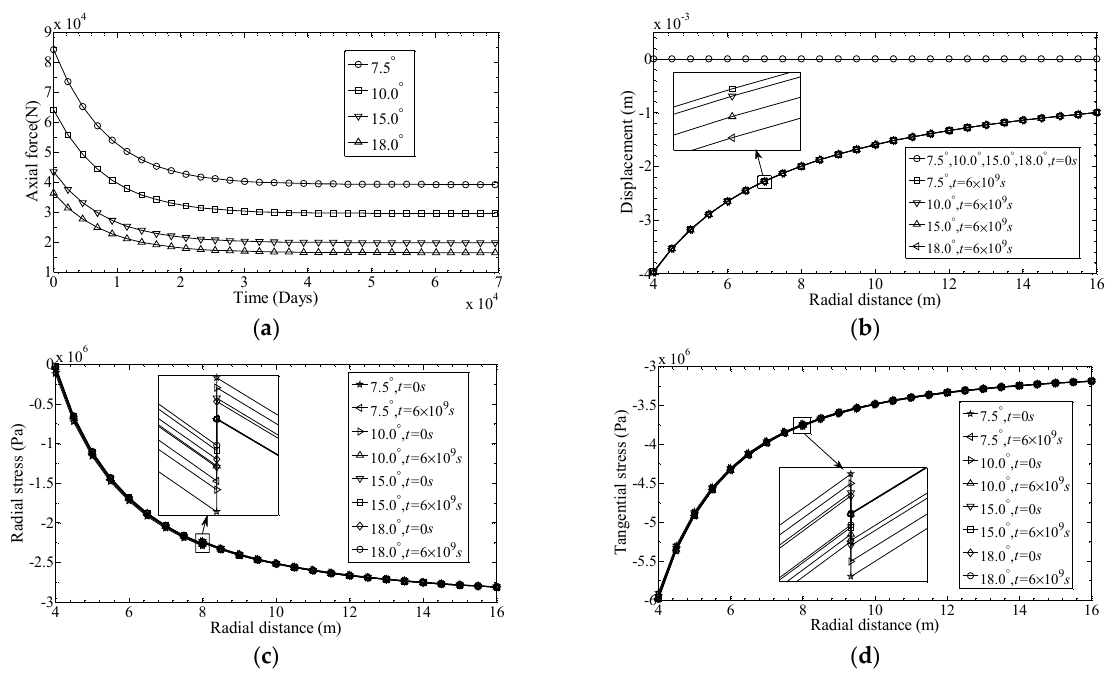
Figure 5. Mechanical states in experiments B, C, D and E. ( a ) Axial force–time curves; ( b ) Displacement–radial distance curves when the time equals zero or 6.0 × 10 9 seconds; ( c ) Radial stress–radial distance curves when the time equals zero or 6.0 × 10 9 seconds; ( d ) Tangential stress–radial distance curves when the time equals zero or 6.0 × 10 9 seconds.